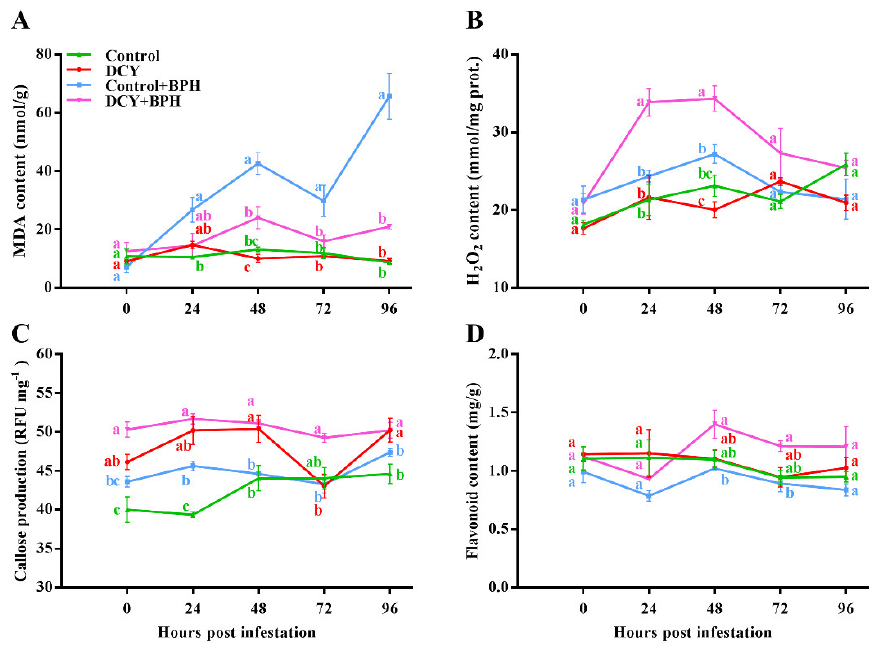
Figure 2. Changes in defense-related compound content in rice sheaths’ responses to DCY treatment and BPH infestation: ( A ) MDA, ( B ) H 2 O 2 , ( C ) callose, and ( D ) flavonoid. Data represent means ± standard error of three replicates. Different letters at a certain time point post-BPH infestation indi- cate significant differences ( p < 0.05, Tukey’s HSD